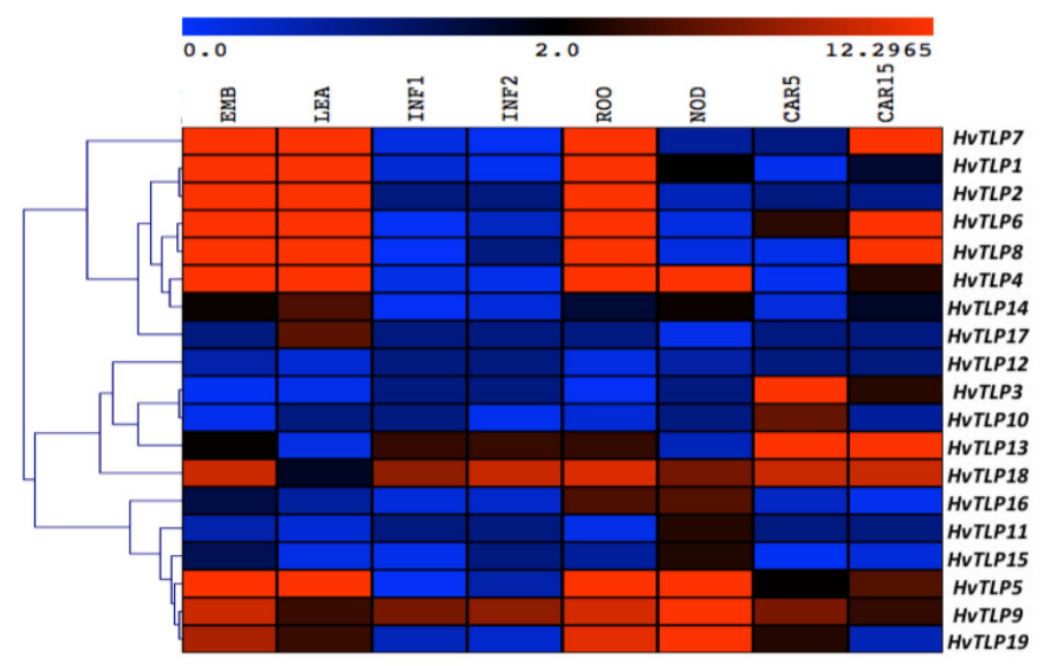
Figure 4. Spatiotemporal expression of HvTLPs genes in different barley tissues. The color scale bar at the top of heat map represents FPKM (Fragments per kilobase of exon model per million reads mapped) normalized log2-transformed values based on “Morex” RNA-seq data, representing high and low expression, respectively. Embry (EMB), shoot (LEA), inflorescences (INF1, INF2), root (ROO), tillers (NOD) and developing grains (CAR5 and CAR15) tissues were used for expression profiling. Details regarding these tissues are explained in Section 2.